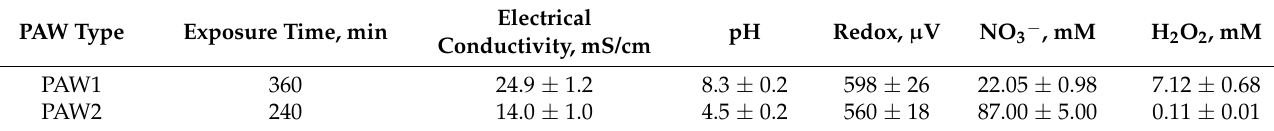
Table 7. Physicochemical properties of the